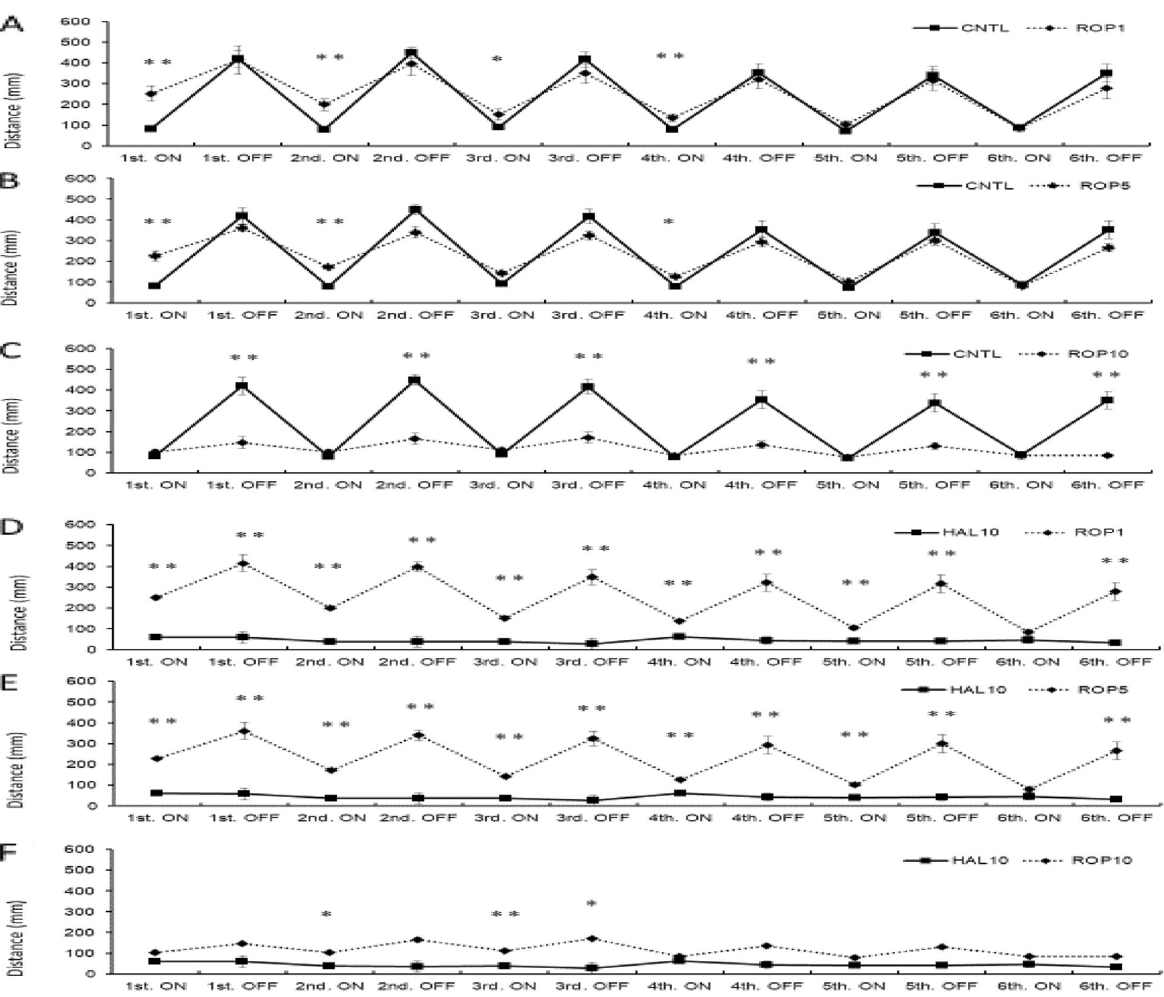
Fig. 7. Effect of ROP on light/dark-stimulatory response. In the ROP 1 mg/L and 5 mg/L groups, the response was enhanced in the first, second, third, and fourth light condition compared to the CNTL ( a , b ); however, all light and dark conditions except sixth light were significantly different from HAL 10 mg/L ( d , e ). In the ROP 10 mg/L group, the response was significantly decreased in all dark conditions compared to the CNTL ( c ); however, the second and third light/dark conditions were significantly different from HAL 10 mg/L ( f ). CNTL: Control, HAL 10: Haloperidol 10 mg/L, ROP 1, 5, 10: Ropinirole 1, 5, 10 mg/L, ON: light-on period, OFF: light-off period. Tukey–Kramer test; * p <0.05, ** p <0.01 from the CNTL vs the HAL 10 ROP groups. All values are presented as means SEMs + ±